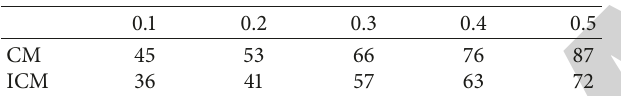
Table 2: Message complexity of CM and ICM compared through simulation.